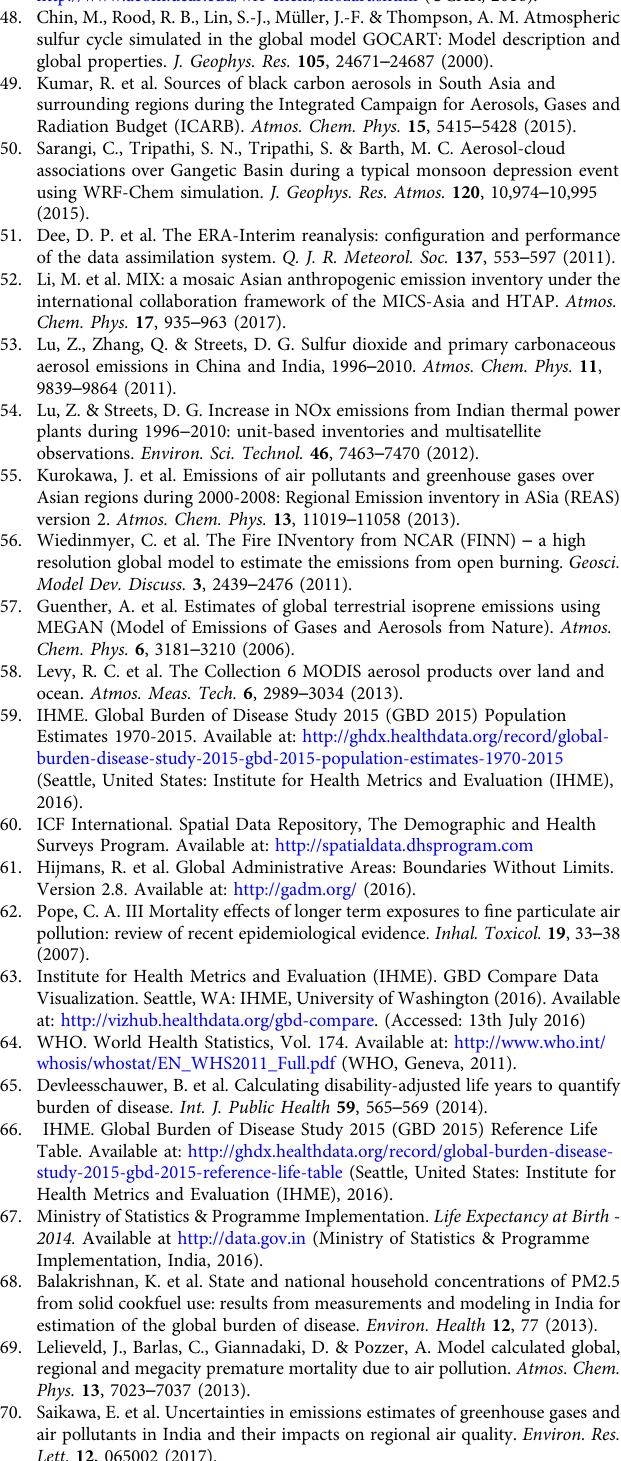
Table. Available at: http://ghdx.healthdata.org/record/global-burden-disease- study-2015-gbd-2015-reference-life-table (Seattle, United States: Institute for Health Metrics and Evaluation (IHME), 2016). 67. Ministry of Statistics & Programme Implementation. Life Expectancy at Birth - 2014. Available at http://data.gov.in (Ministry of Statistics & Programme Implementation, India, 2016). 68. Balakrishnan, K. et al. State and national household concentrations of PM2.5 from solid cookfuel use: results from measurements and modeling in India for estimation of the global burden of disease. Environ. Health 12 , 77 (2013). 69. Lelieveld, J., Barlas, C., Giannadaki, D. & Pozzer, A. Model calculated global, regional and megacity premature mortality due to air pollution. Atmos. Chem. Phys. 13 , 7023 – 7037 (2013). 70. Saikawa, E. et al. Uncertainties in emissions estimates of greenhouse gases and air pollutants in India and their impacts on regional air quality. Environ. Res. Lett . 12 , 065002